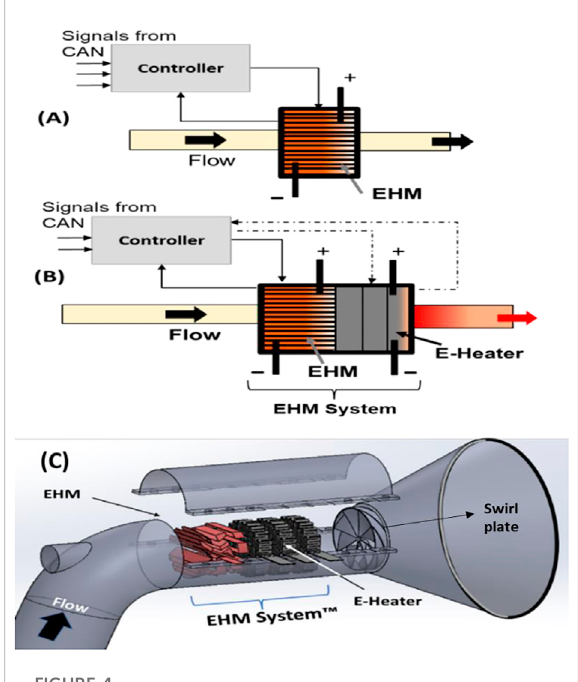
TABLE 1 Advanced system catalyst speci fi